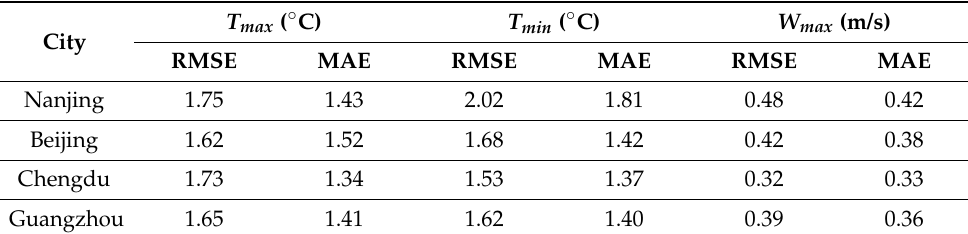
Table 2. The RMSE and MAE values corresponding to Nanjing, Beijing, Chengdu, and Guangzhou (holonomic factor subset).